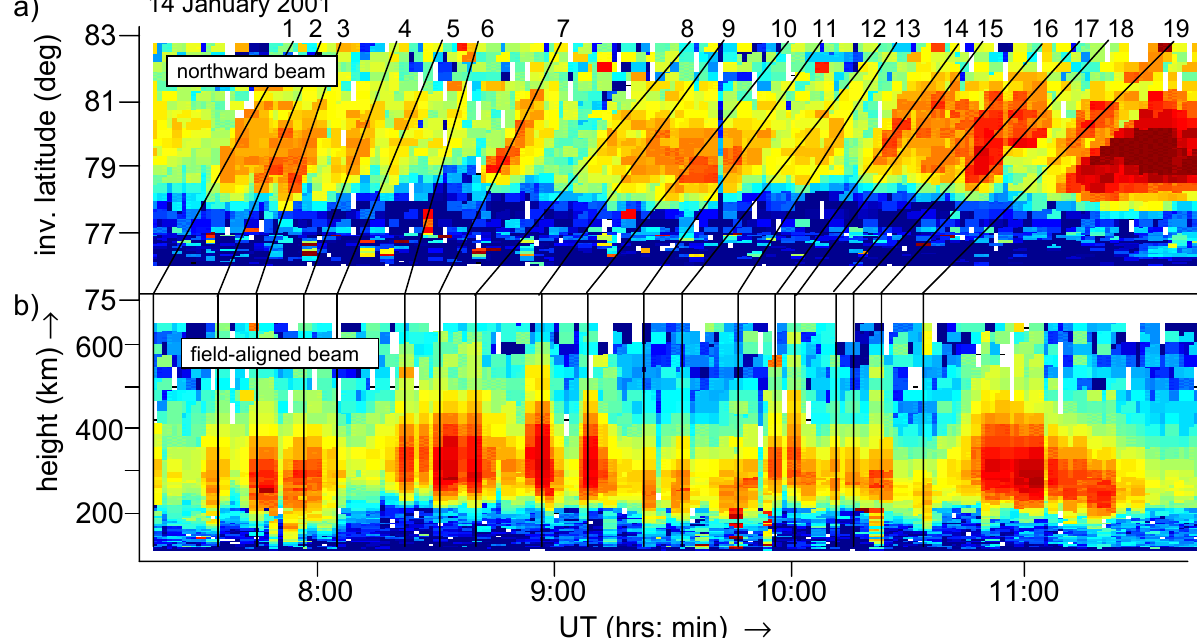
Fig. 5. Two-minute post-integrations of the ESR radar observations of plasma concentration in the interval between 07:15–11:45UT. (a) is for the low-elevation, northward beam and (b) is for the field-aligned beam, and the plasma concentration is contoured as a function of invariant latitude and observation time in the top panel and as a function of altitude and observation time in the lower panel. (The contour levels are given by the scale shown for the top panel of Fig. 6). Lines map the centres of poleward-moving events seen in the low-elevation beam back to the invariant latitude of 75.1 ◦ of the field-aligned